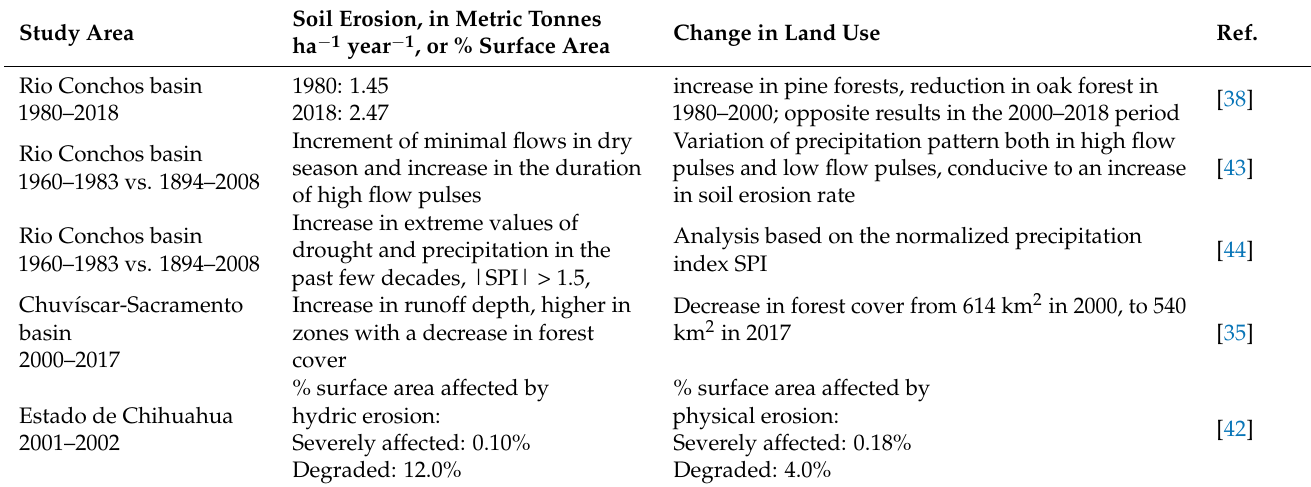
Figure 4. Soil erosion by water and terrain deformation (photos by the author). Table 2. Hydric soil erosion within the Rio Conchos Basin.